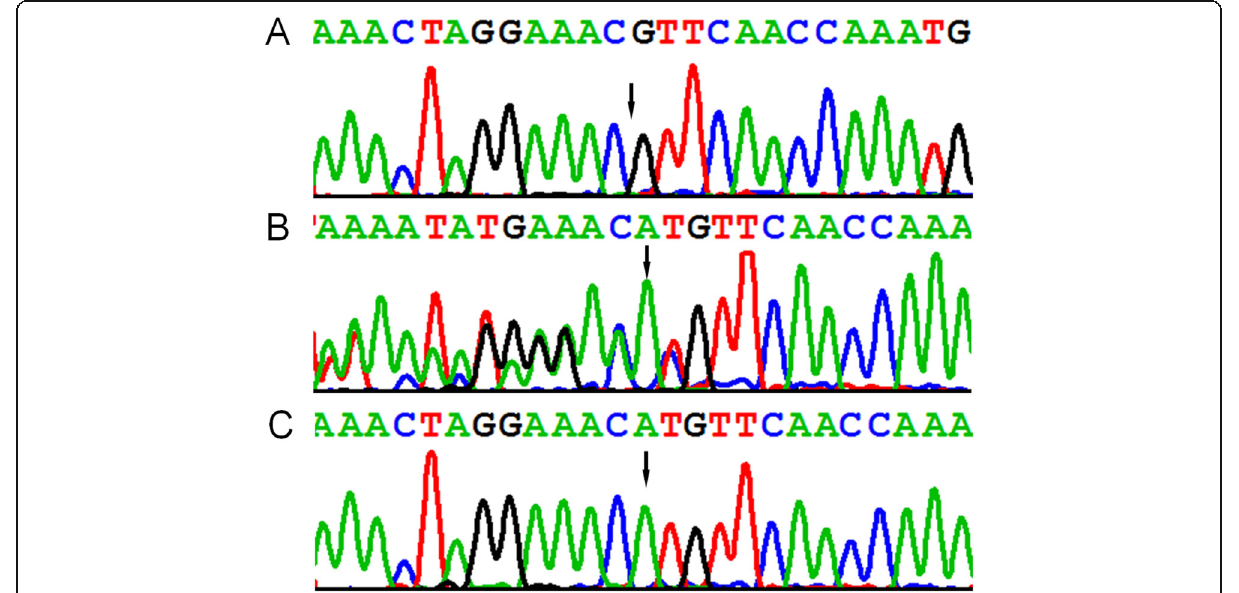
Fig. 3 Sanger sequencing chromatograms show a frameshift variant c.718_719delAT/ p.Met240fs in the proband ( a ) and his mother ( b ), not in